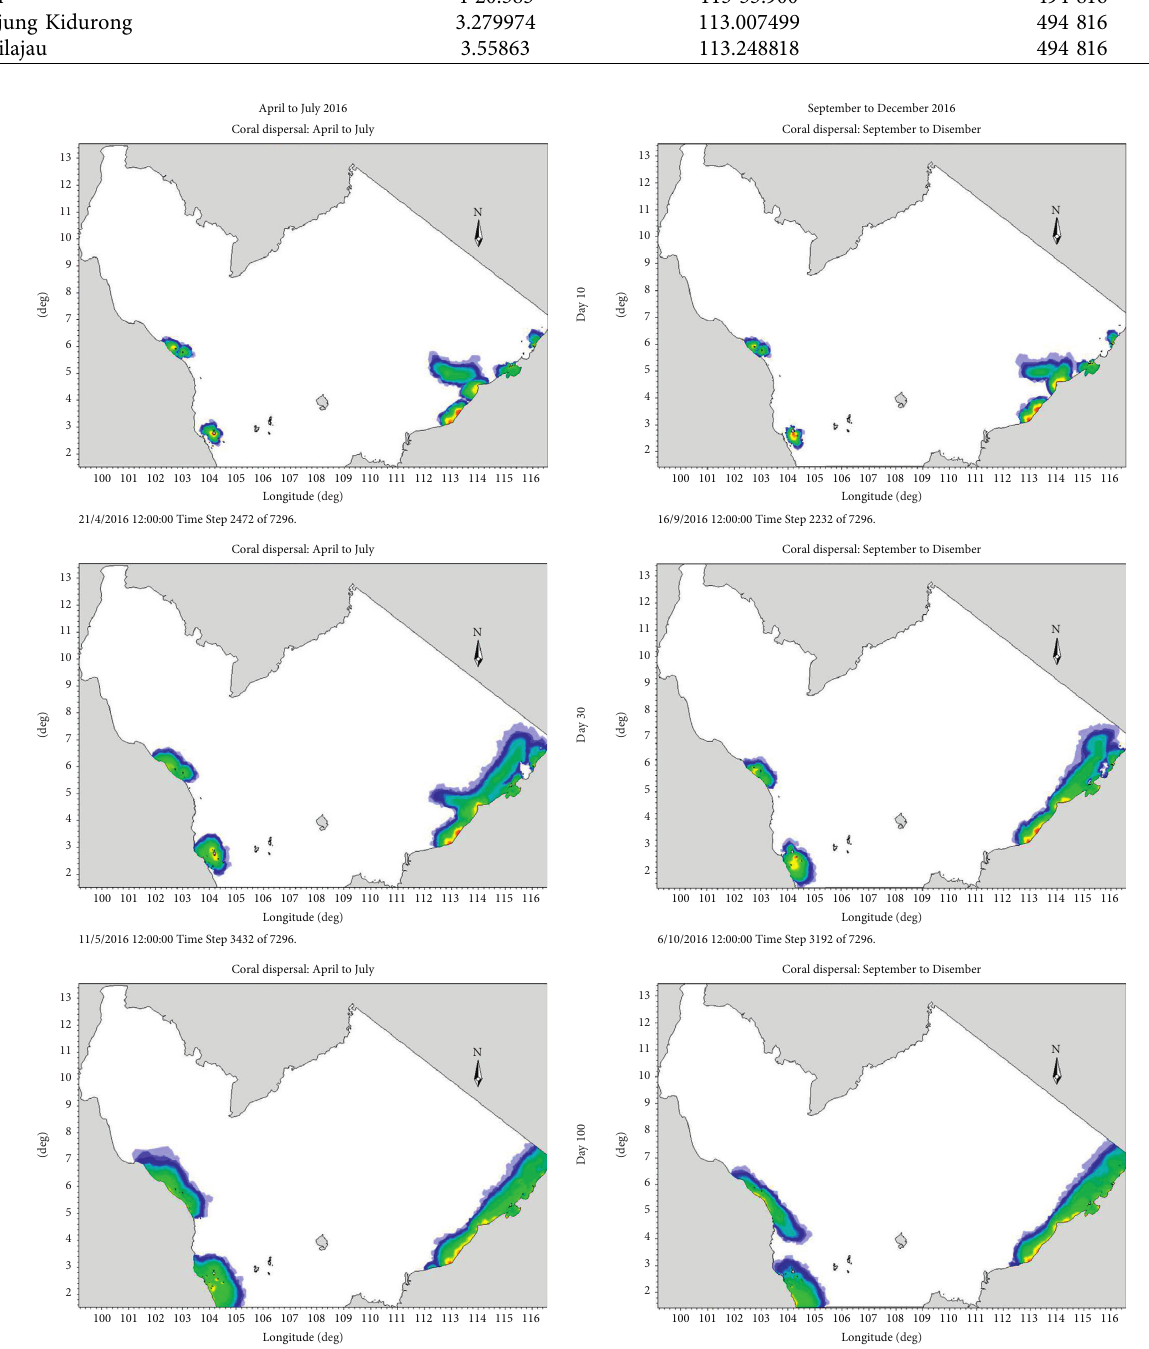
Figure 9: Coral particle dispersion simulation for April to July and September to December cycles in 2016. The pattern was captured on 10 days, 30 days, and 100 days,